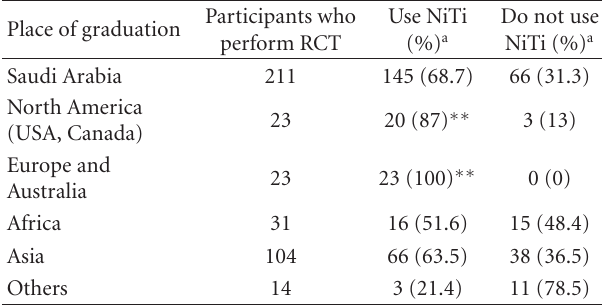
Table 4: Response details for NTRF usage and place of graduation.